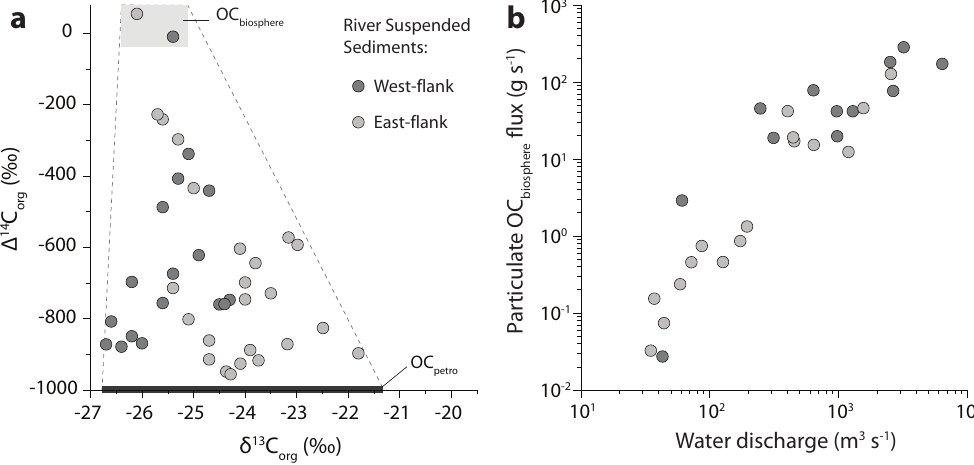
Figure 2. Isotopic compositions and flux of particulate OC eroded from the terrestrial biosphere (OC biosphere ) for Taiwan’s rivers. (a) Stable and radioactive isotope compositions of organic carbon ( δ 13 C org and ∆ 14 C org , ‰) of suspended sediments from rivers in Taiwan. Analytical errors are smaller than the point size. Samples from catchments draining the two flanks of the mountain belt define a mixing domain between organic carbon from the terrestrial biosphere (OC biosphere ) and petrogenic OC (OC petro ) from bedrocks. (b) Instantaneous particulate flux of OC biosphere (gs − 1 ) as a function of water discharge during floods in the sampled catchments, demonstrating a strong hydrological control on OC biosphere